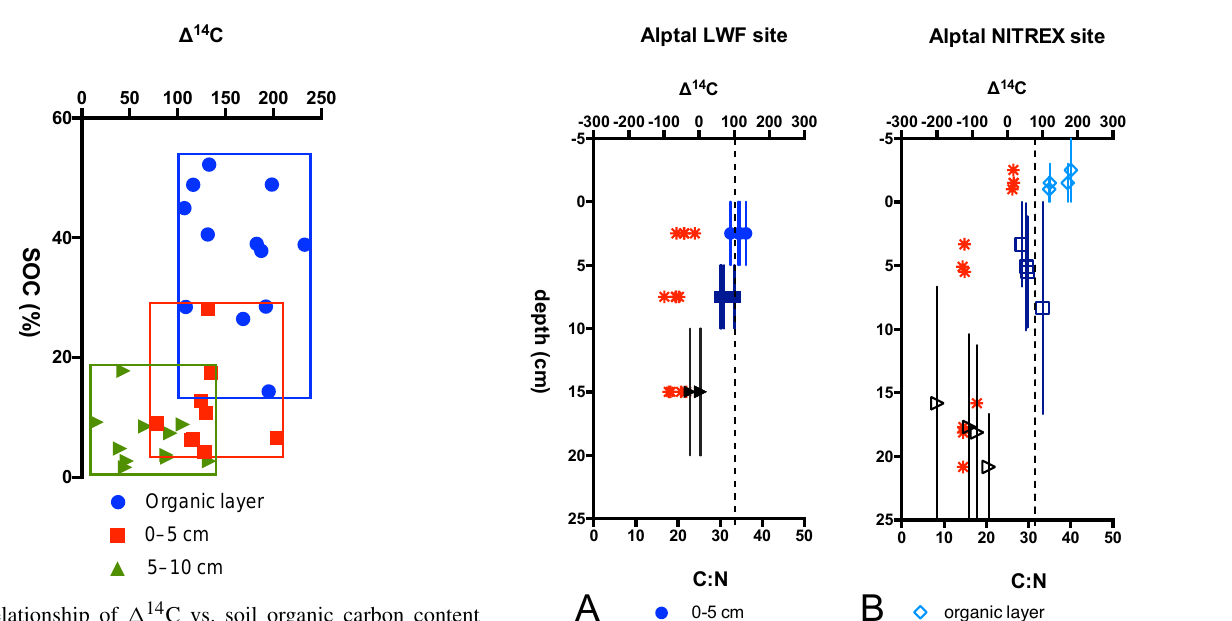
Figure 3. Relationship of (cid:49) 14 C vs. soil organic carbon content (SOC) on the regional scale within Switzerland ( n = 12 sites), with each sample representing the average of four cores covering an area of 400m 2 . Samples were taken in between 1995 and 1998. Trends show decreasing variability of soil organic carbon content with depth, but no significant changes in the variability of (cid:49) 14 C contents with soil depth. Analytical errors are smaller than symbol sizes and are not visible (between 6–8‰ (cid:49) 14 C). Table 2. Overview variability of (cid:49) 14 C and standard deviation across regions and horizons converted to mean residence time (MRT) and coefficient of variation (CV).